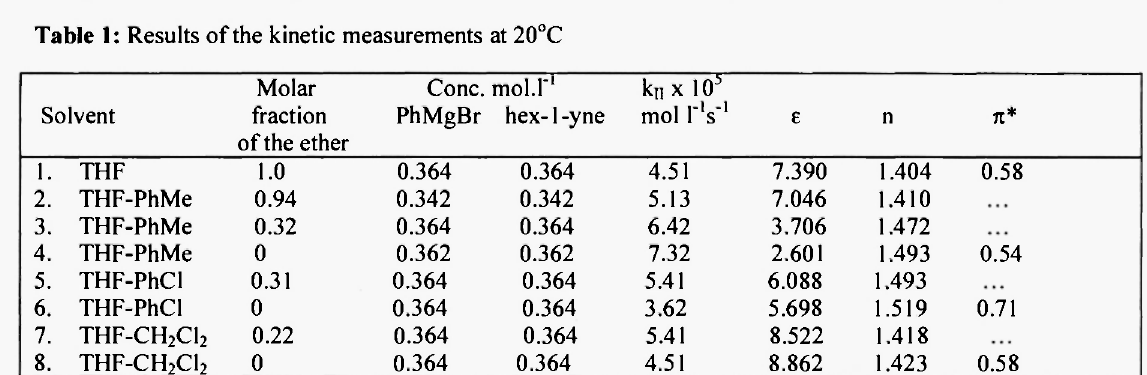
Table 1 : Results of the kinetic measurements at 20°C Molar Cone. mol.r